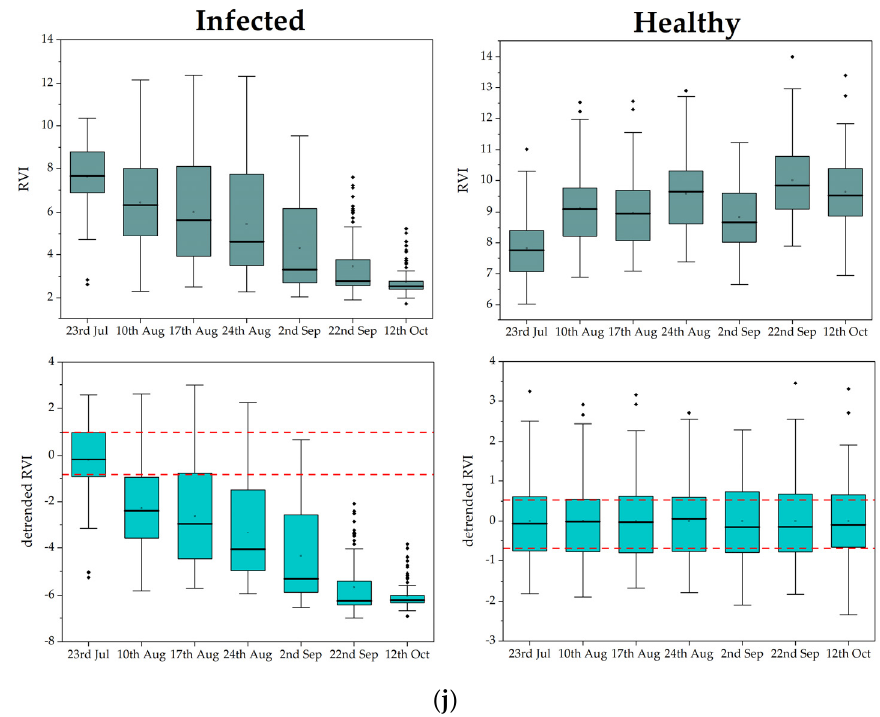
Figure A1. Multitemporal change in each parameter. Upper and lower red dotted lines indicate the extent of the “no-change” region. The no-change region was defined as the 25th and 75th percentiles of the spectral value prior to infection (20 June 2020). The black horizontal line is the median line; the diamond point an abnormal value; and the square point in the middle of the box is the mean value. The range of the box line is 1.5 IQR. ( a ) NDRE; ( b ) LCI; ( c ) red edge; ( d ) NIR; ( e ) red; ( f ) PSRI; ( g ) NWI; ( h ) VARI; ( i ) NDVI; ( j ) RVI. Table A1. Confusion matrix for several key days.